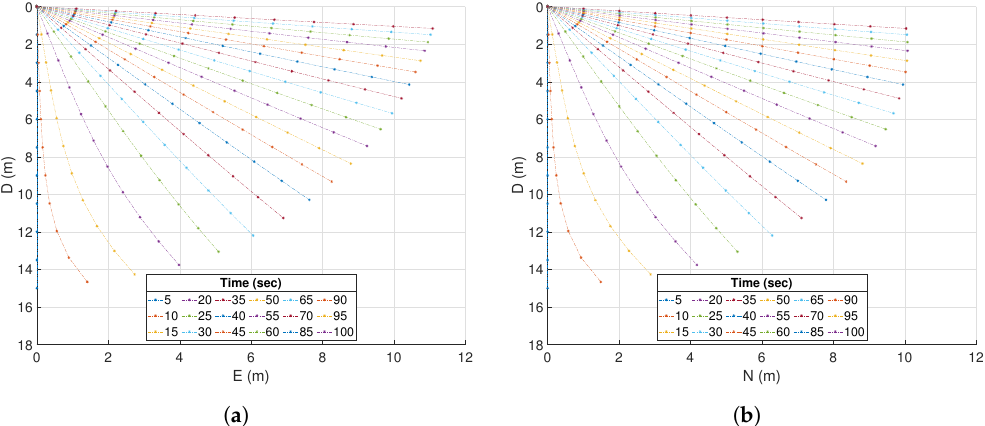
Figure 10. Cross-section of the tether and ROV in the North ( b ), East ( a ) and Down direction from time 0 to 100